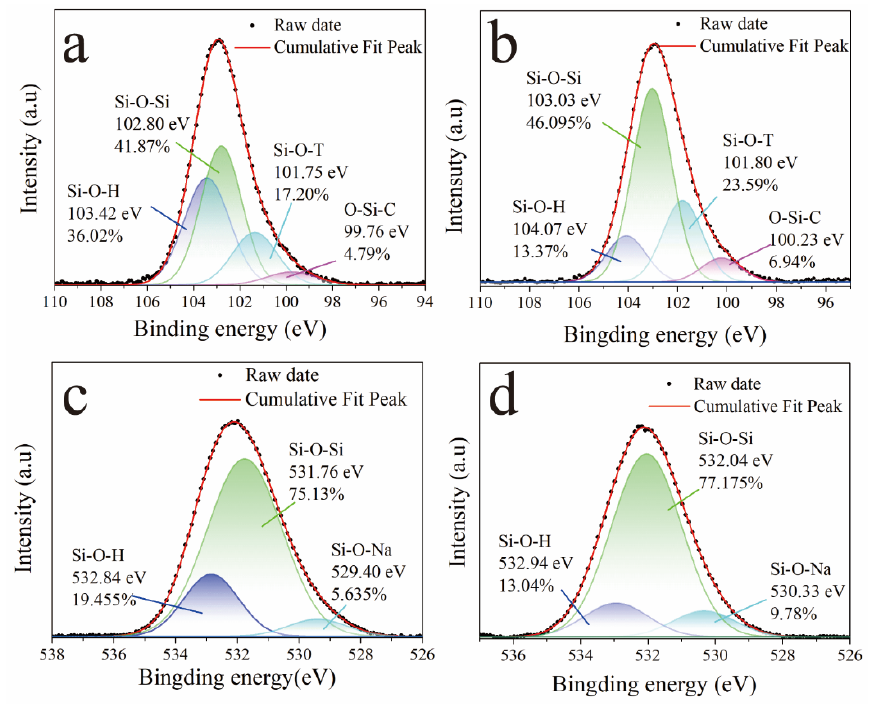
Figure 5. XPS narrow scan: ( a , b ) Si 2p spectra of GPs and GP-SHCs, ( c , d ) O 1s spectra of GPs and GP-SHCs coating.